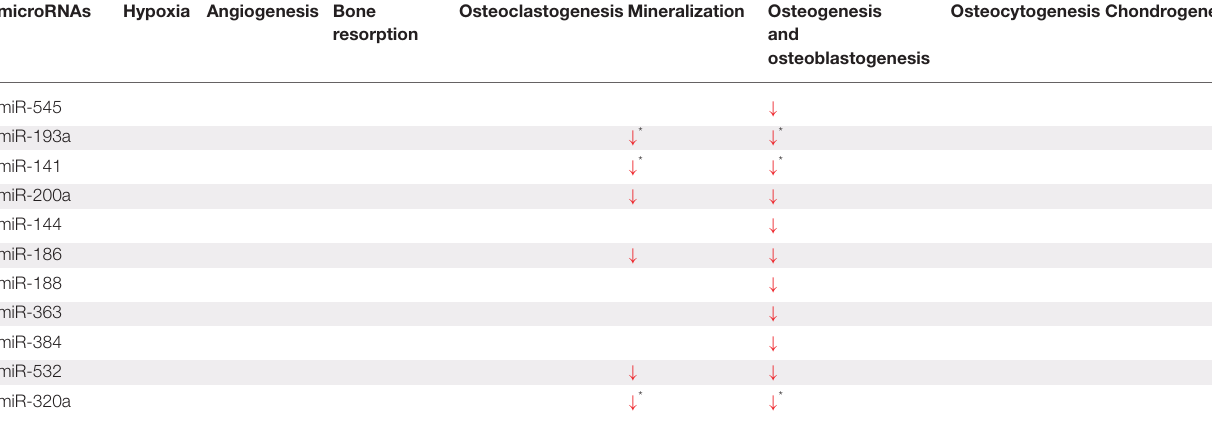
Green upward arrows depict a positive effect of the specific miRNA on the aspect related to fracture healing. Red downward arrows depict a negative effect of the specific miRNA on the aspect related to fracture healing. ∼ depicts controversial effects regarding the specific miRNA on the aspect related to fracture healing. * depicts that the specific miRNA in the relevant aspect has been researched in a human